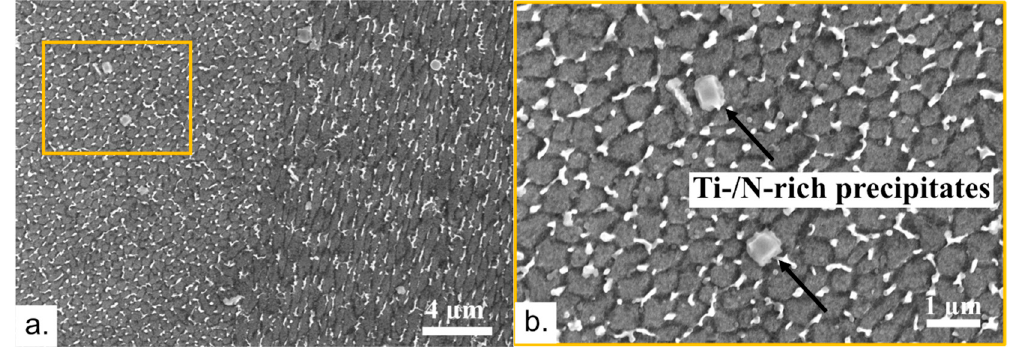
Figure 2. (a) Fine Ti- and N-rich precipitates of more irregular shape randomly distributed within the matrix. (b) These have been identified using EDS and are pointed out by black arrows in the close-up image.